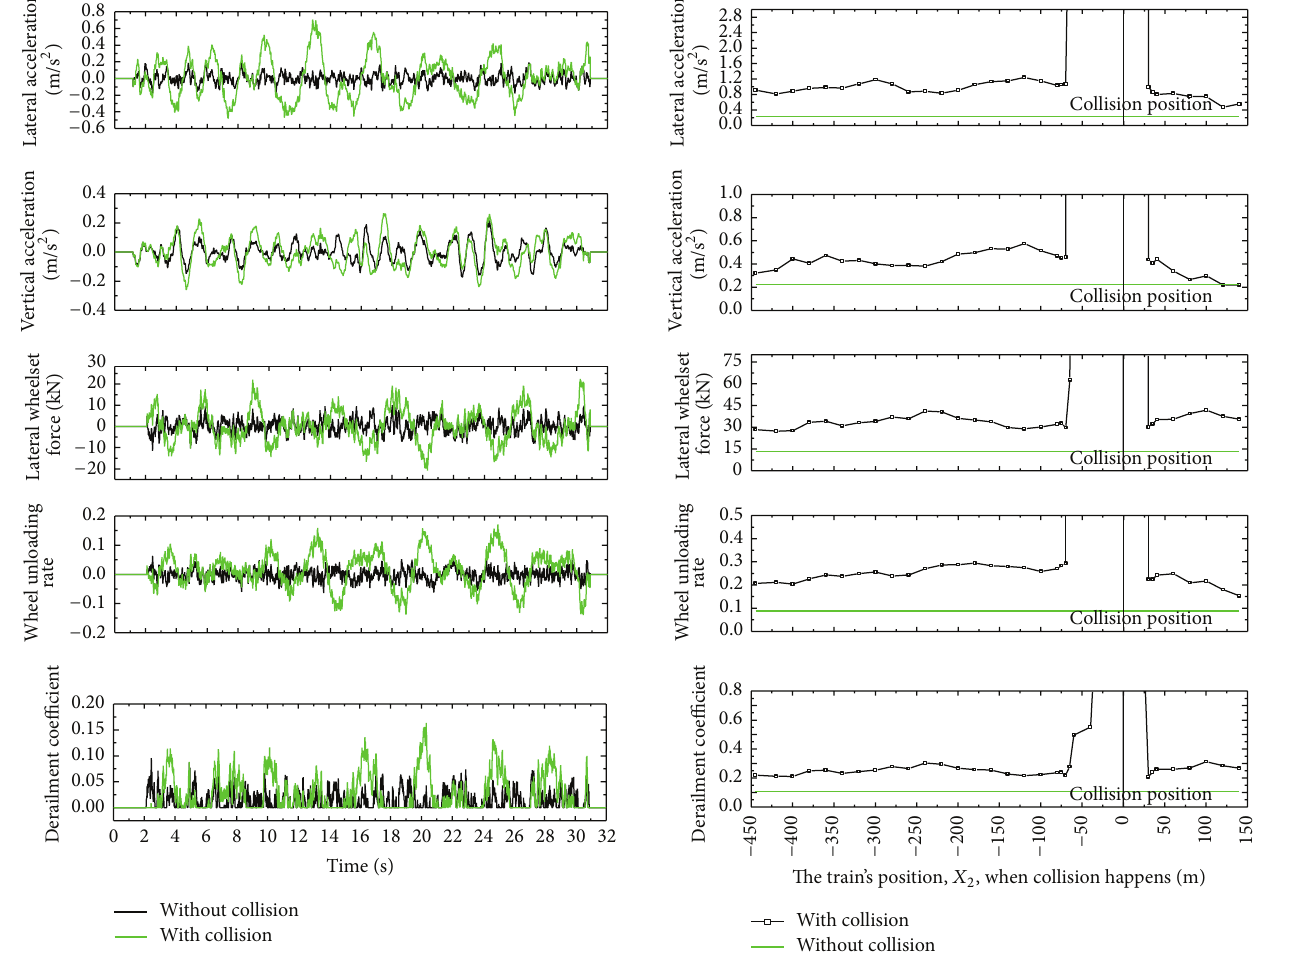
Figure 17: Influence of the train’s position when collision